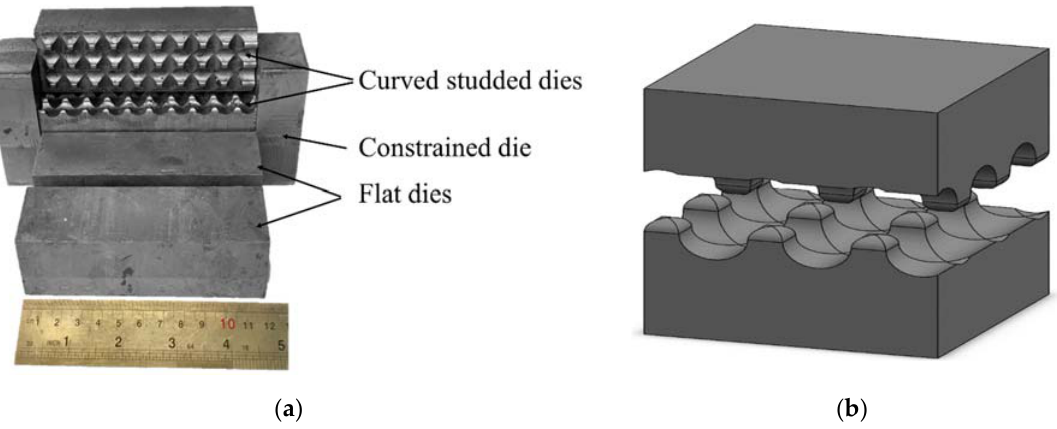
Figure 2. ( a ) Flat and studded modified ‐ CSP dies, ( b ) 3D view of modified ‐ CSP